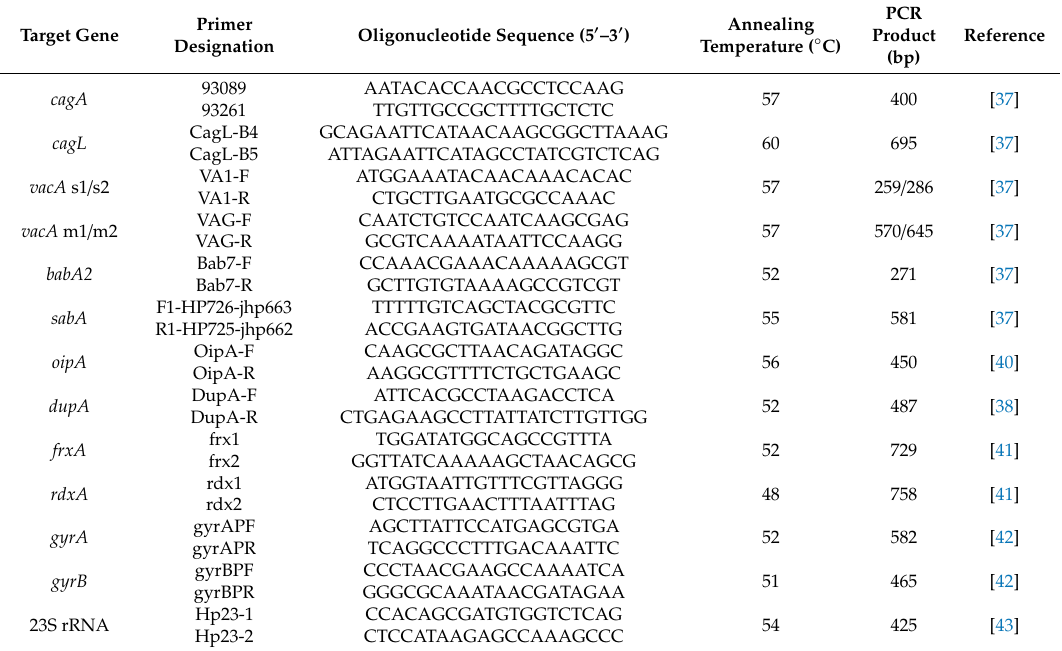
Table 1. Oligonucleotide primer sequences used for amplification of genes involved in H. pylori antibiotic